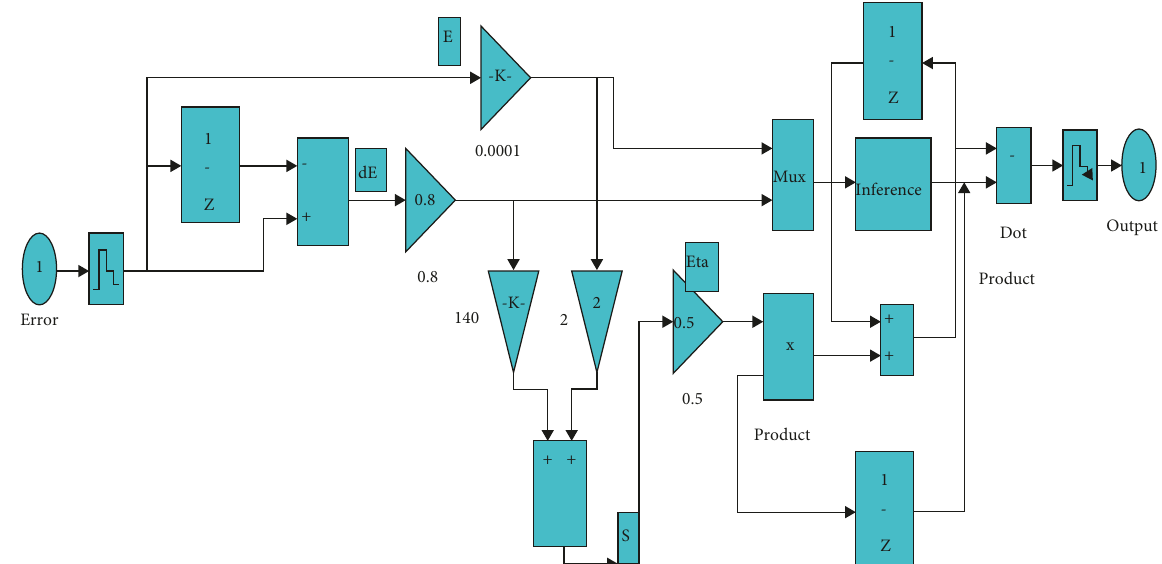
Figure 13: Execution of neuro-fuzzy controllers with the adapted torque control